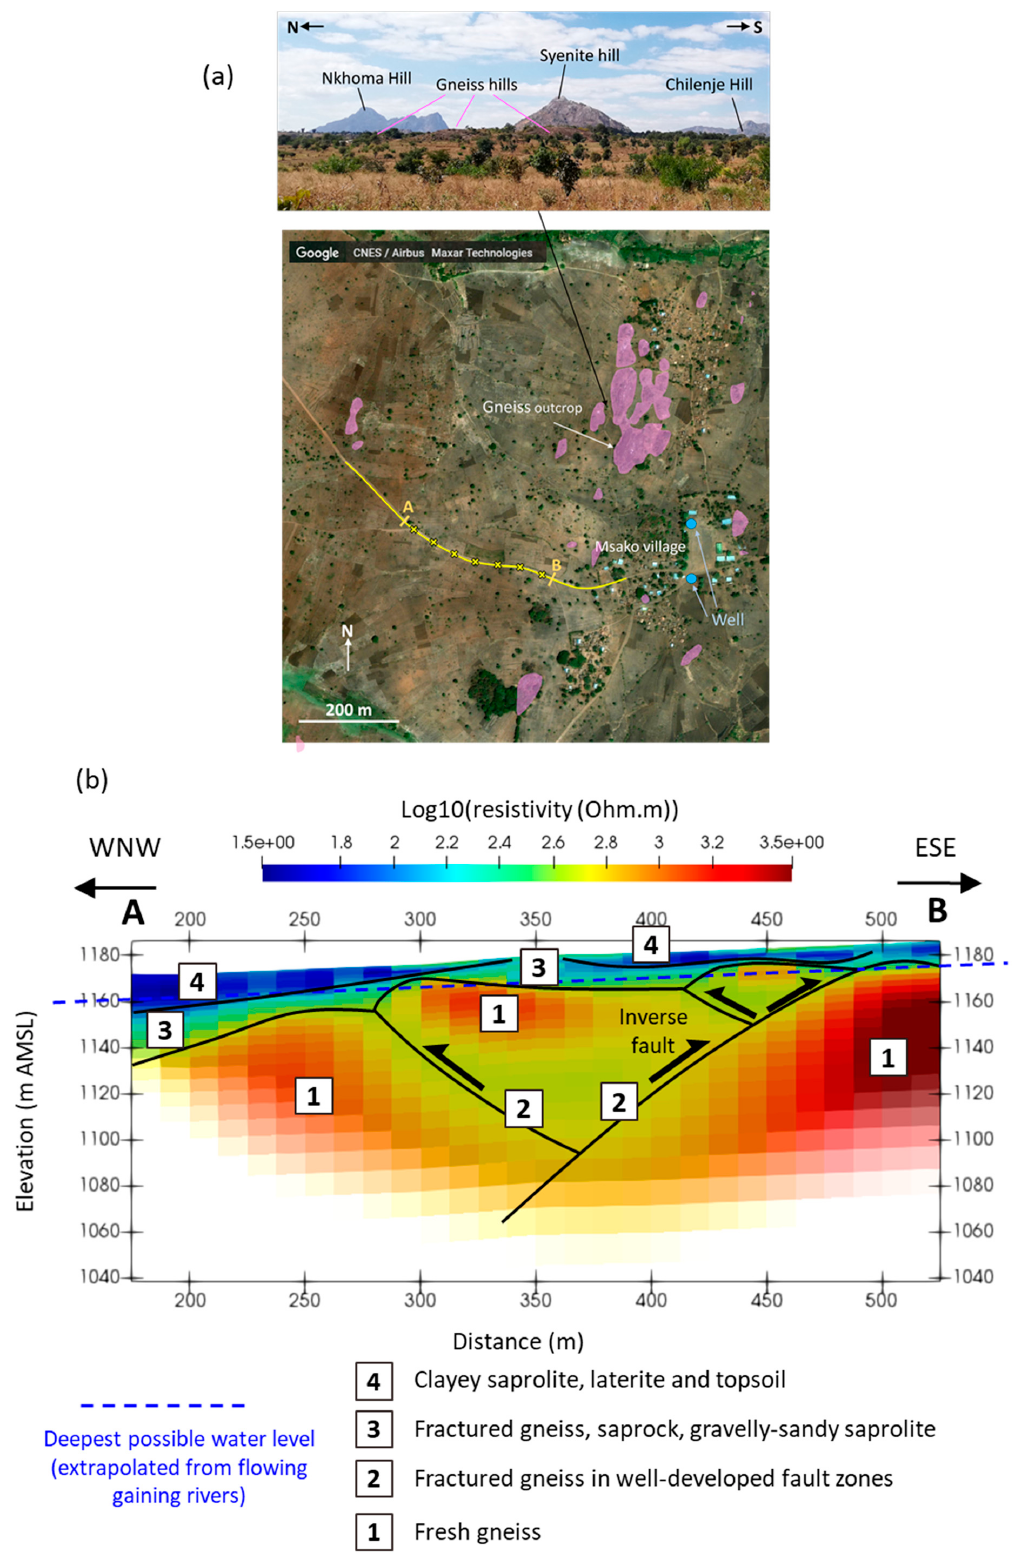
Figure 7. Msako survey: ( a ) site survey line location (with individual sounding mid points marked as crosses) shown on a Google Earth satellite image (July 2020 download) of the area with accompanying landscape photograph; and, ( b ) interpreted subsurface resistivity cross-section obtain for section line AB marked on ( a